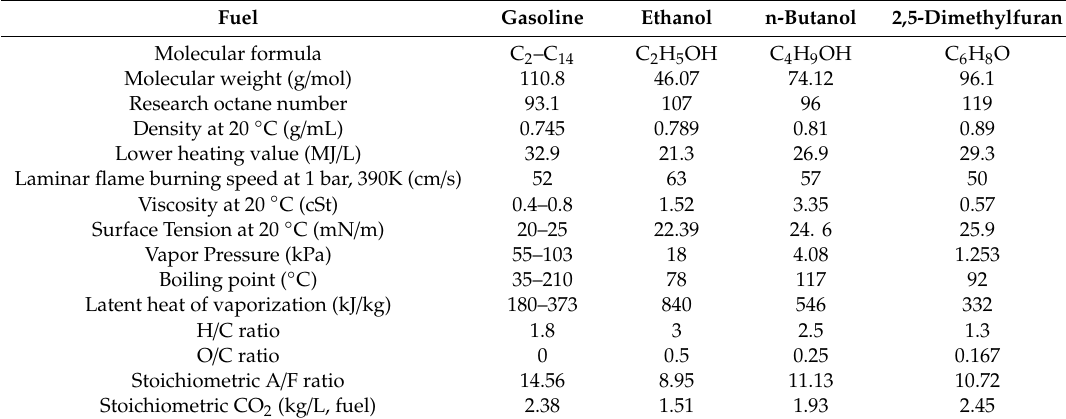
Table 4. Physical and chemical properties of three oxygenated fuels and gasoline [36,45,46].